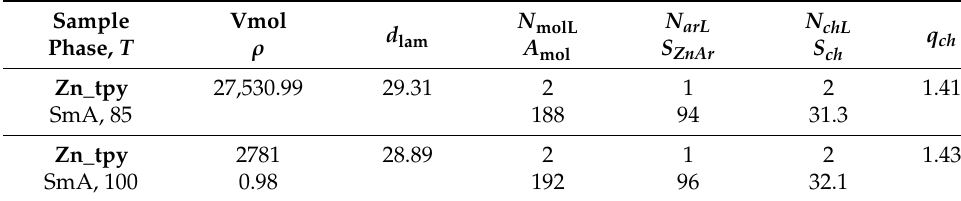
Figure 4. Mesomorphic behaviour of Zn(II) coordination complexes: Cr—crystalline phase; SmA— smectic A mesophase; M hex —three-dimensional mesophase with a two-dimensional hexagonal lat- tice symmetry, Col h : two-dimensional columnar hexagonal mesophase. DSC data on the second cooling cycle.